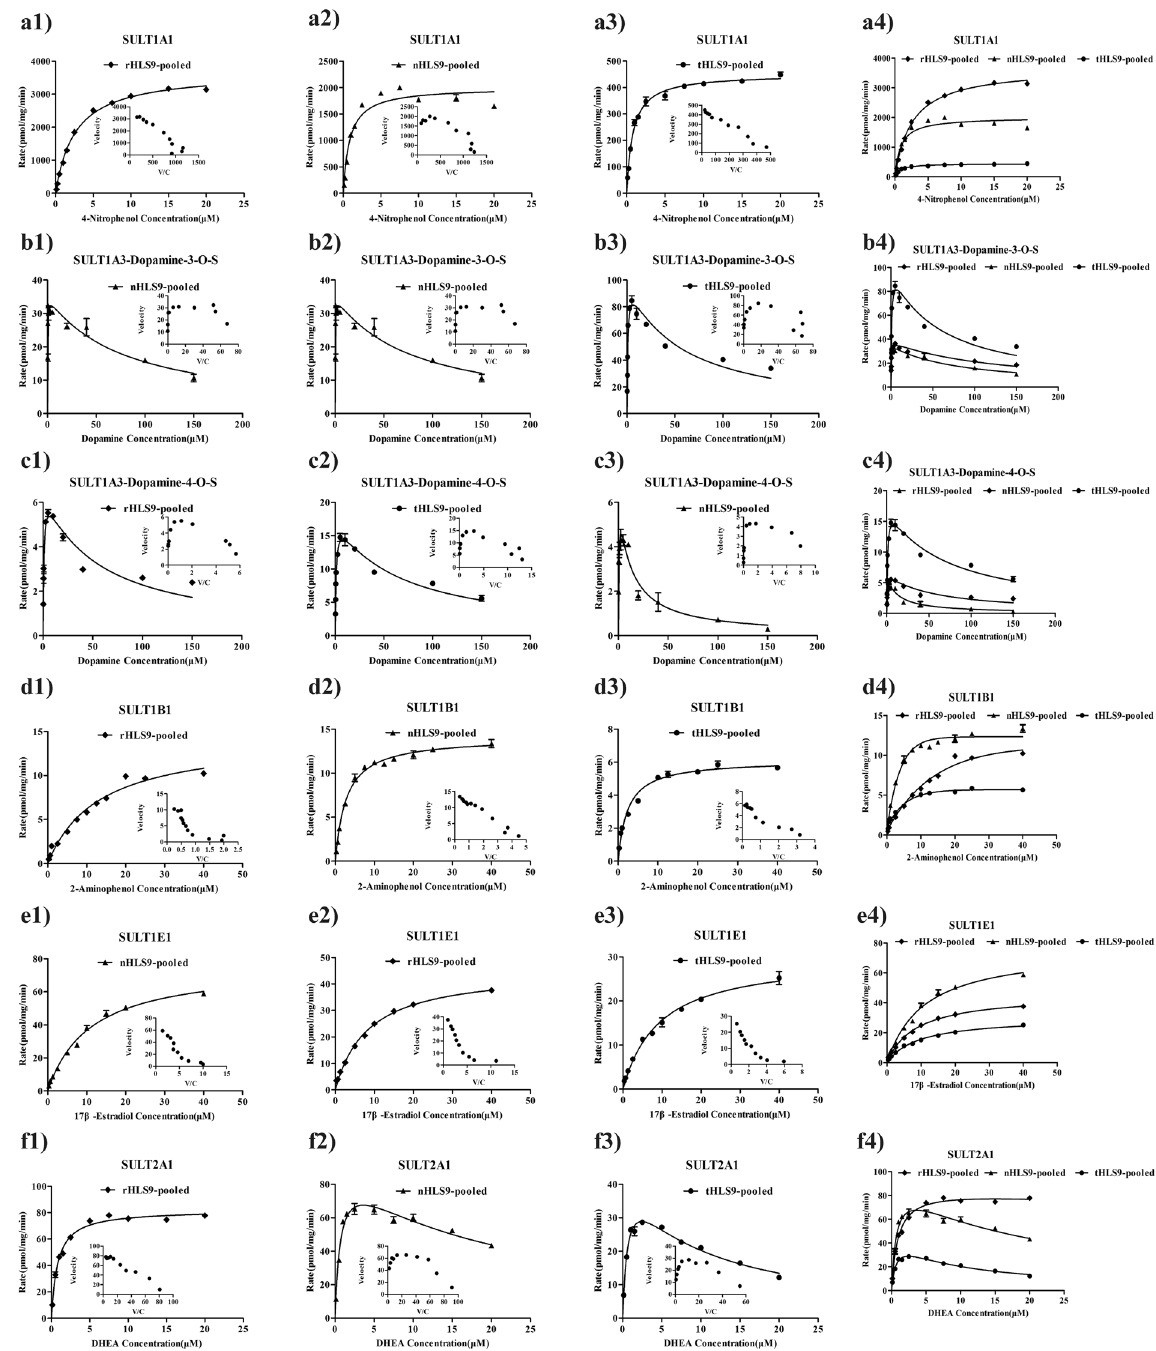
Figure 3. Enzyme kinetic analysis for the measurement of the activities of the five SULTs in rHLS9-pooled (( a1 – f1 ), diamonds), nHLS9-pooled (( a2 – f2 ), triangles), and tHLS9-pooled (( a3 – f3 ), circles) through specific probe substrates. In each figure, the inset shows the Eadie-Hofstee plot. ( a4 – f4 ) show the comparison among the activities of the SULT isoforms in rHLS9-, nHLS9-, and tHLS9-pooled. Each data point represents an average of three determinations, and the error bar represents the SD of the mean (n =